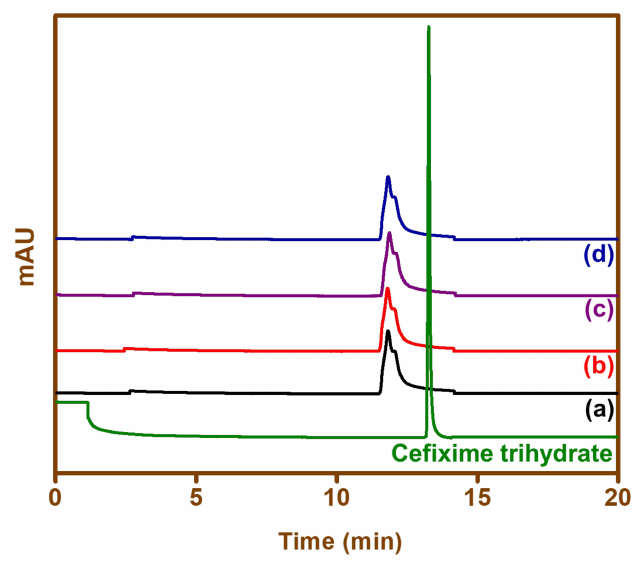
Figure 9. HPLC chromatograms showing cefixime trihydrate and samples of cefixime trihydrate